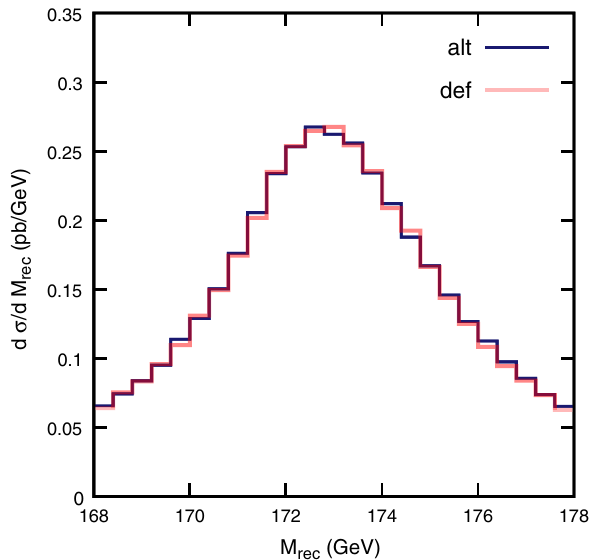
Fig. 5 Invariant mass distribution of the reconstructed top quark mass, defined as the mass of the W + j B or W − j ¯ system, produced with the B bb4l generator, at the 8 TeV LHC. The two distributions are obtained with the default implementation of radiation from b quarks (def), and with the new implementation presented here (alt)